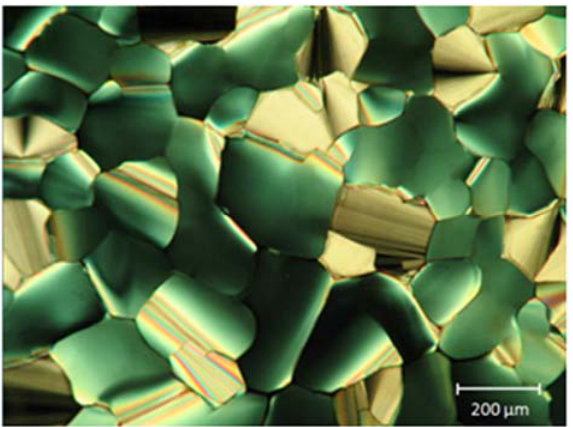
10 ºC/min. The photograph was taken when the sample was at 120  C.